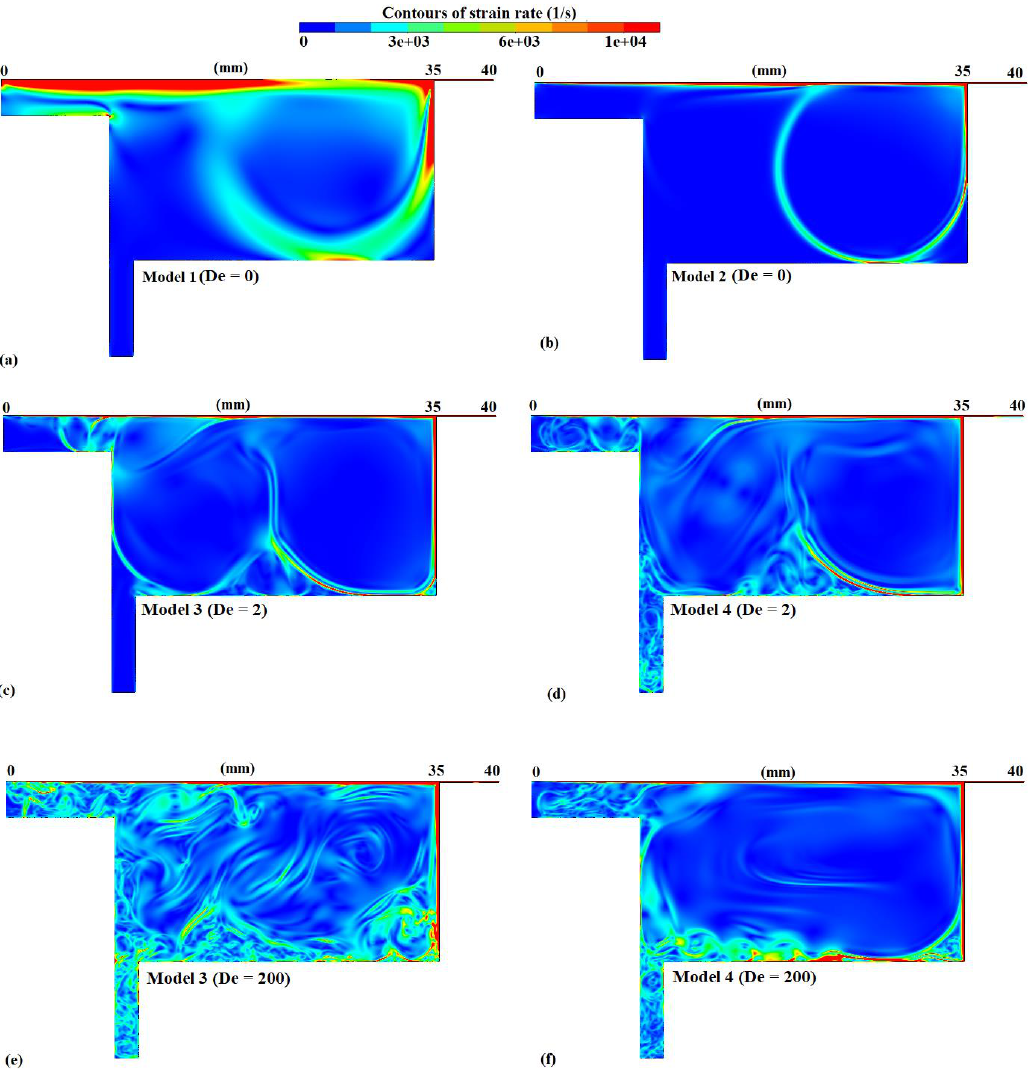
Figure 8. Strain rate distribution for ( a ) model 1, ( b ) model 2, ( c ) model 3 ( De = 2), ( d ) model 4 ( De = 2), ( e ) model 3 ( De = 200), and ( f ) model 4 ( De = 200).